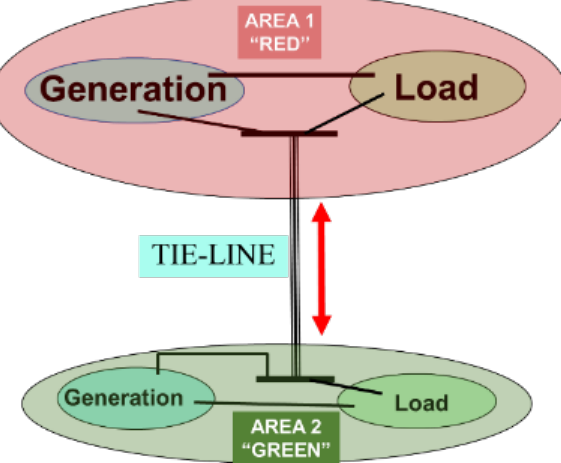
Figure 5. A Two-Area Power System.